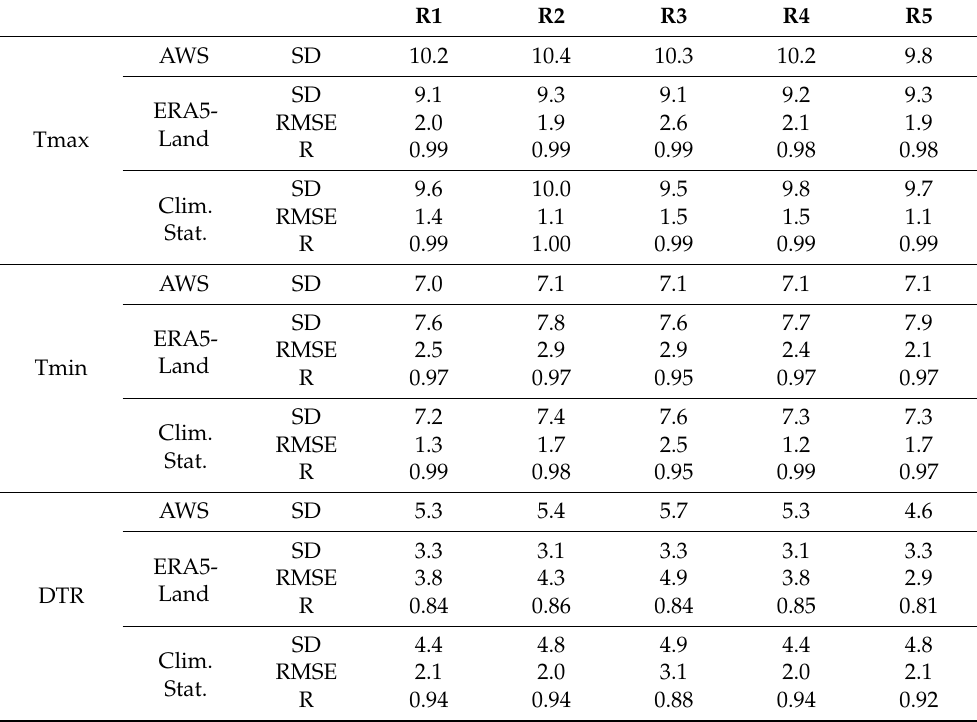
Table 5. Average of standard deviation (SD), centered root-mean-square error (RMSE), and Pear- son correlation coefficient (CC) for T max , T min and DTR for five regionally representable AWSs, corresponding ERA-Land data, and closest climatological